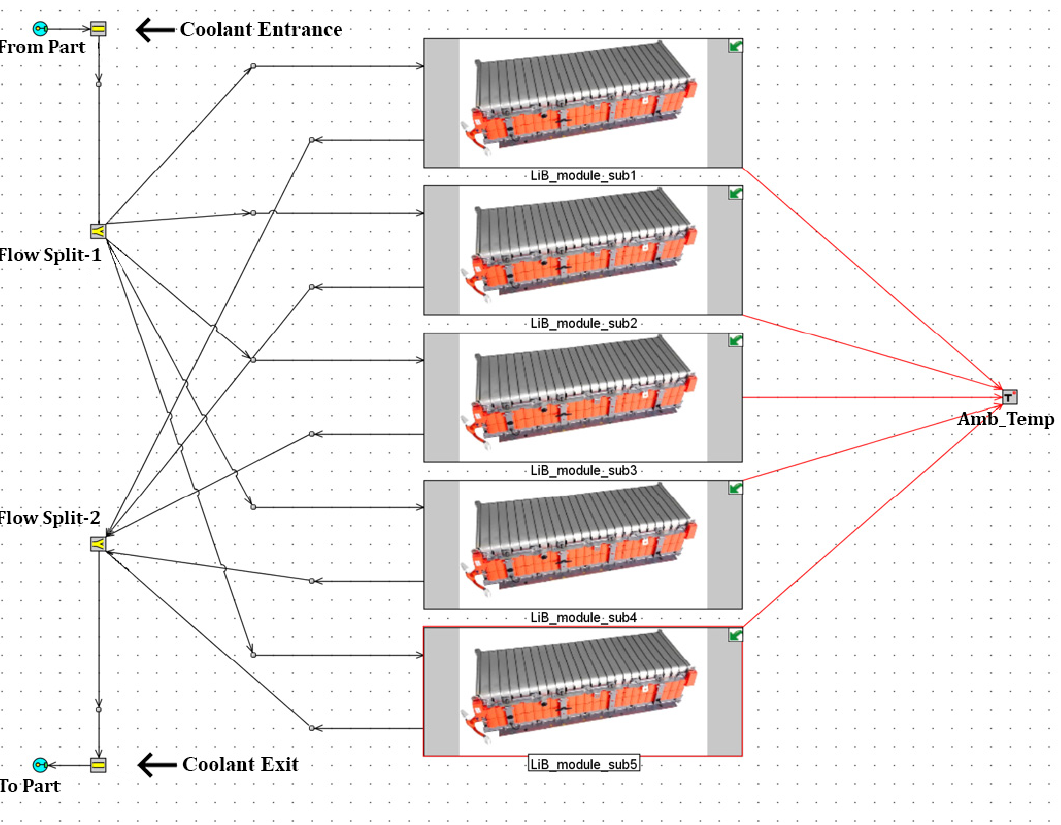
Figure 5. A battery pack modeling